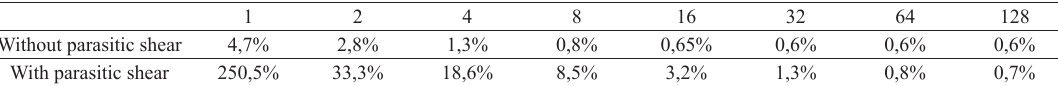
Figure 6. ( a ) Third frequency for different ply fiber directions for the clamped-free (CF) beam computed using the parasitic shear finite element model; ( b ) Third frequency for different ply fiber directions for the clamped-free (CF) beam computed using the corrected finite element model. Table 2. Error values in the first natural frequency (CF).